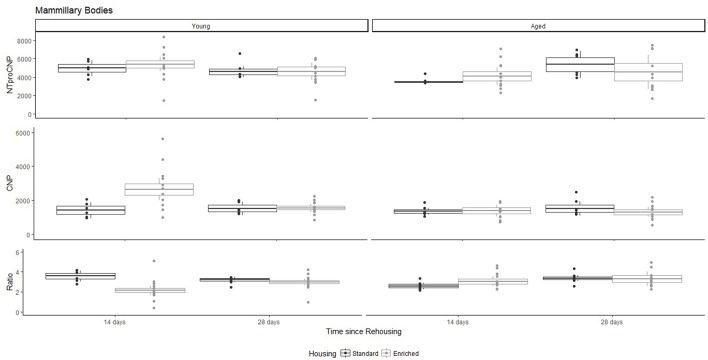
Concentration (femtomoles/g wet tissue) of NTproCNP (Top), CNP (Middle), and NTproCNP:CNP ratio (Bottom) within mammillary bodies. Summary data is 20% trimmed means (resulting in a reduction of n = 2 for all groups), standard error (box) and 95% confidence interval (whisker), overlaid by individual data points. For NTproCNP: Aged rats = Young rats. For CNP: Young-Enriched-14-day > Aged overall = Other Young rats. For Ratio: Young-Enriched-14-day < Aged overall = Other Young rats.